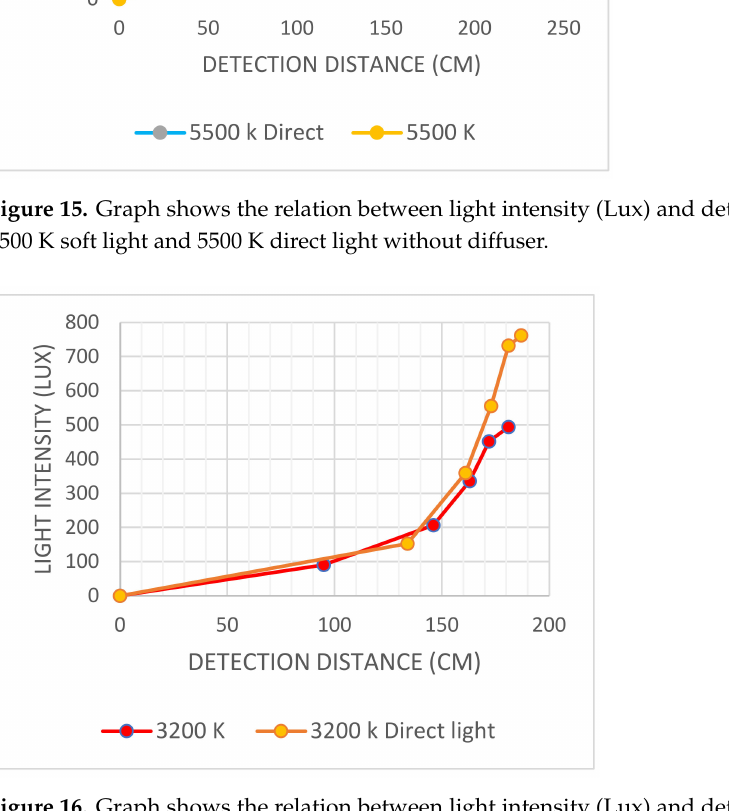
Figure 16. Graph shows the relation between light intensity (Lux) and detection distance (cm) for 3200 K soft light and 3200 K direct light without